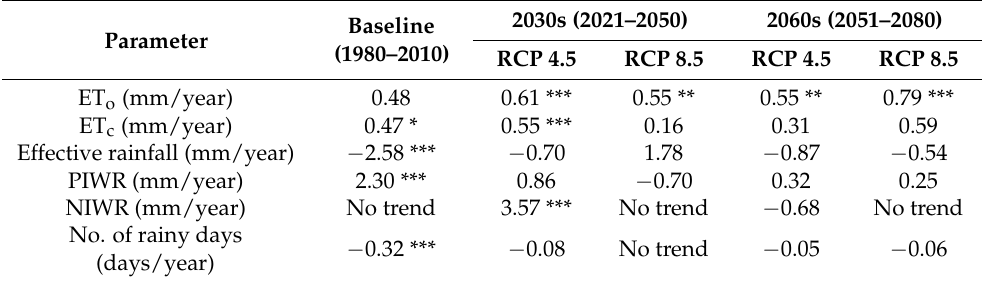
Asterisks represent the significance level according to the MK test. *, **, and *** represent α = 10, 5, and 1%, respectively. The values without symbols are